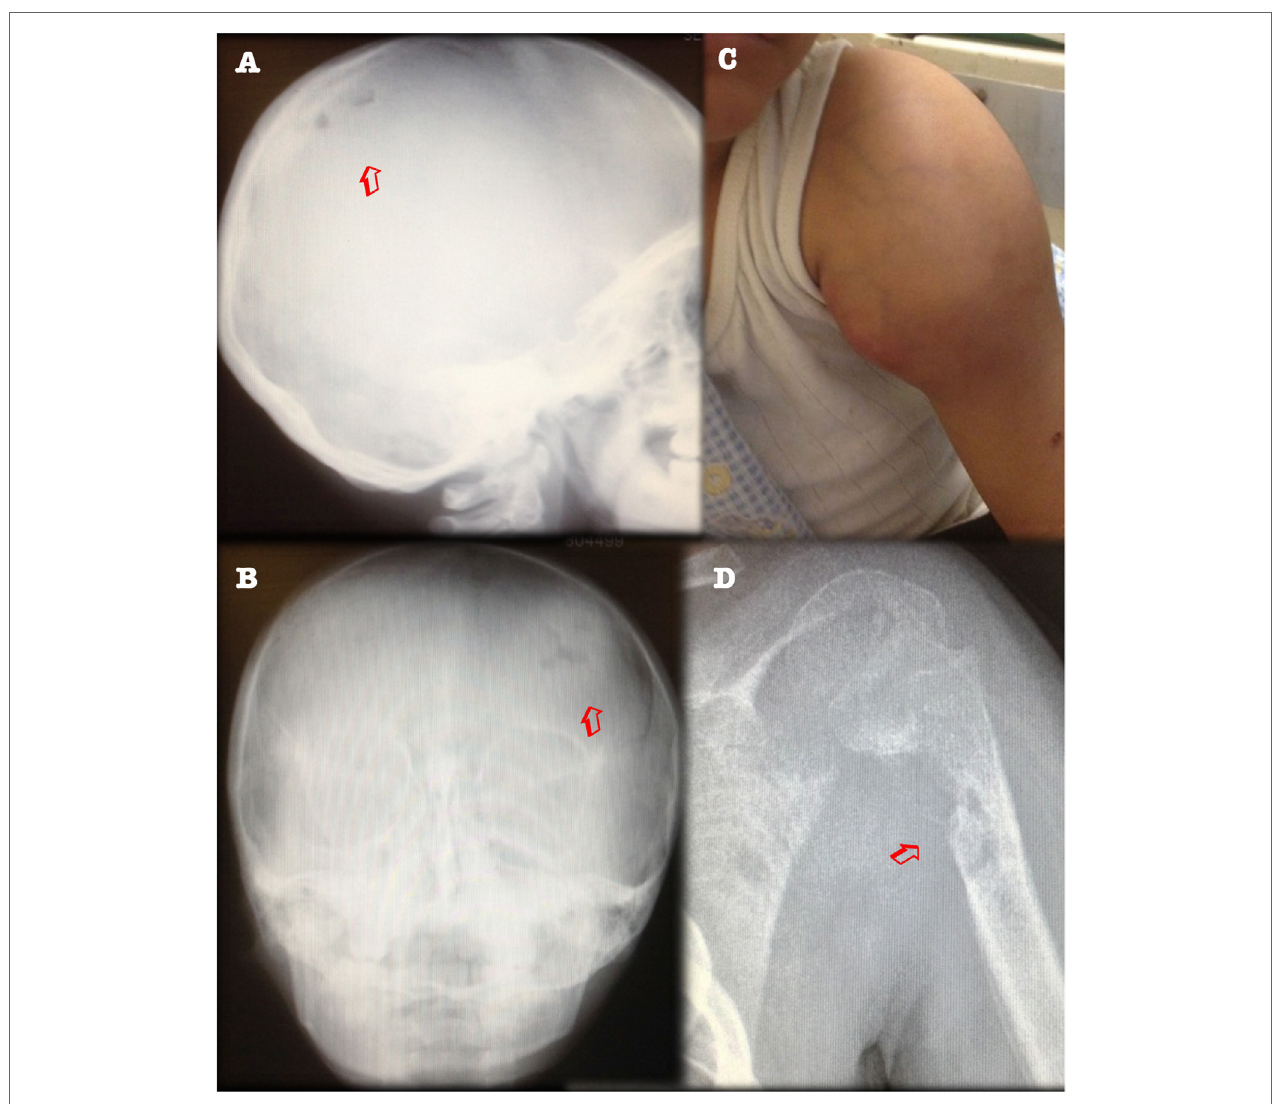
FIGURe 2 | Clinical relapse with upper arm abscess, and new lytic lesions in parietal bone (left panels) and left humerus (right panels) . (a) X-ray of skull, lateral view. (B) Posteroanterior view, showing osteolytic lesions (arrows). (C) Swelling of left shoulder over abscess. (D) X-ray of left humerus showing osteolytic lesions